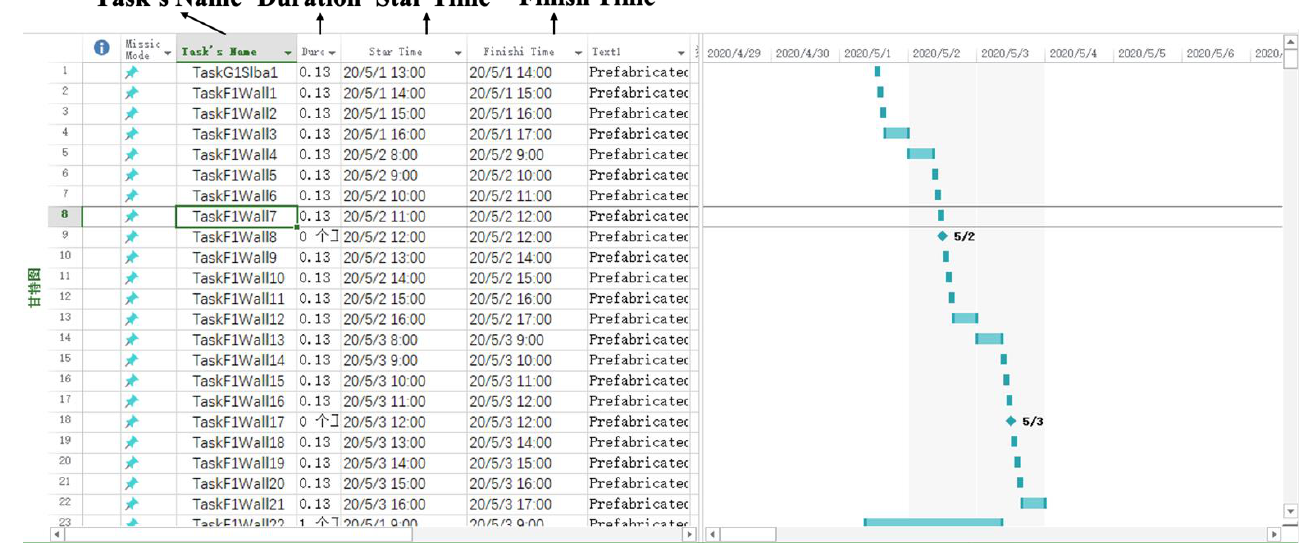
Figure 13. Importing construction management information into project.